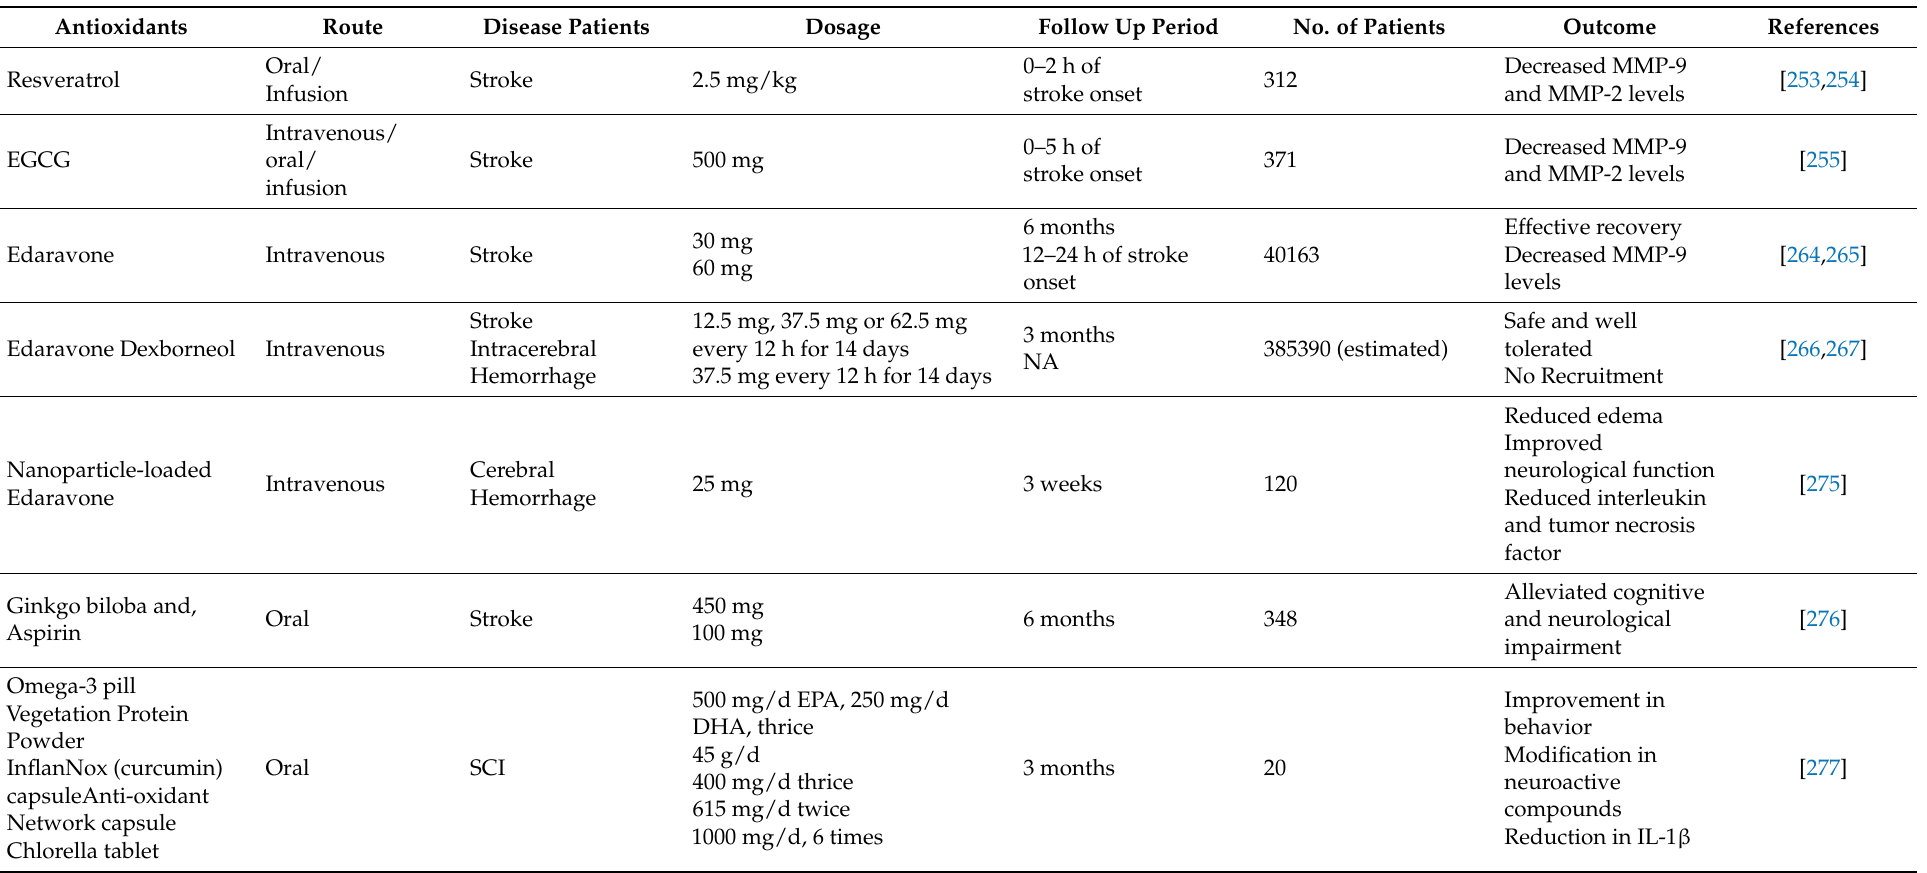
Table 2. Clinical trials with antioxidants in neurological